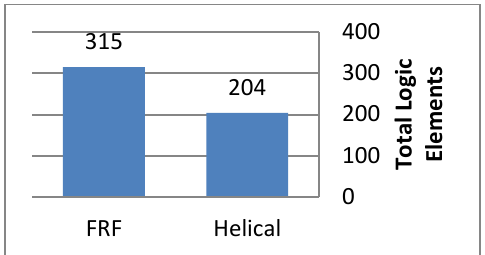
Figure 14. Total number of logic elements required for the FPGA implementation of the FRF and helical interleavers of size 128 × 128.